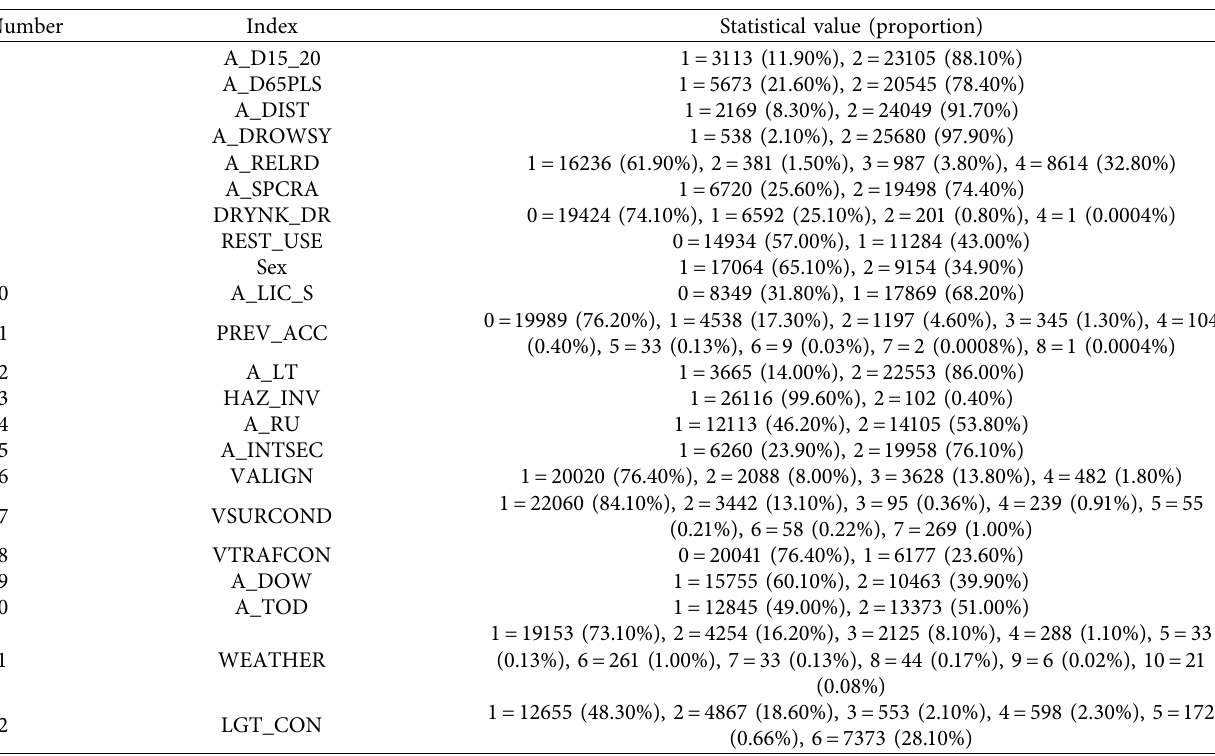
Table 2: Descriptive